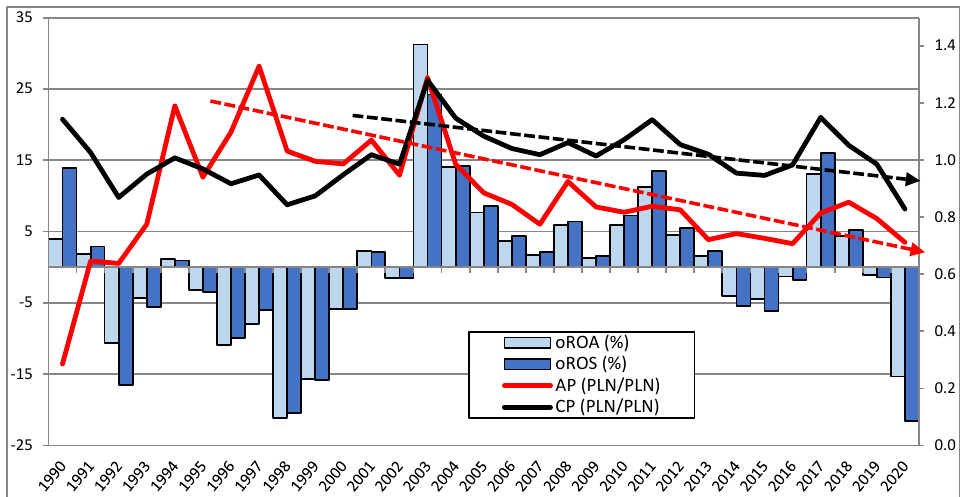
Figure 4. Productivity of assets (AP) and costs (CP), and operating return on assets (oROA) and sales (oROS) of coal mining enterprises in 1990 – 2020. Note: productivity of assets and costs — right axis. Source: as in Figure 1.